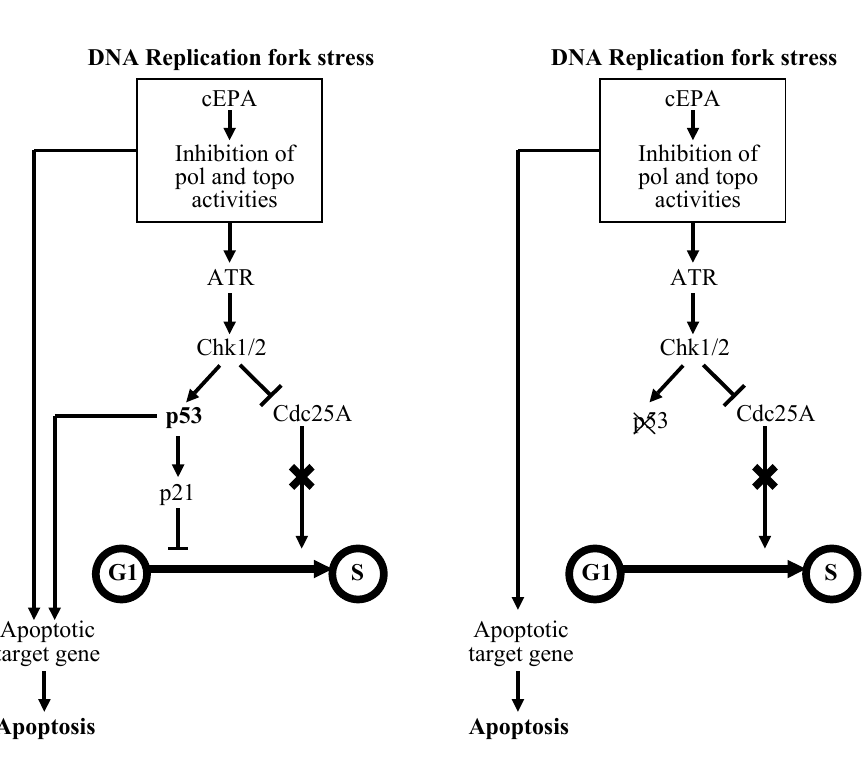
Figure 7. Role of p53 in the prevention of cell cycle arrest and cell death by cEPA. (A) DNA replication fork inhibitors such as cEPA activate p53 that triggers p21 activation and prevents the cell cycle from G1 to S phase development. (B) The lack of p53 leads to cell cycle arrest in the G1 phase by Cdc25A and results in apoptosis of virtually the entire cell